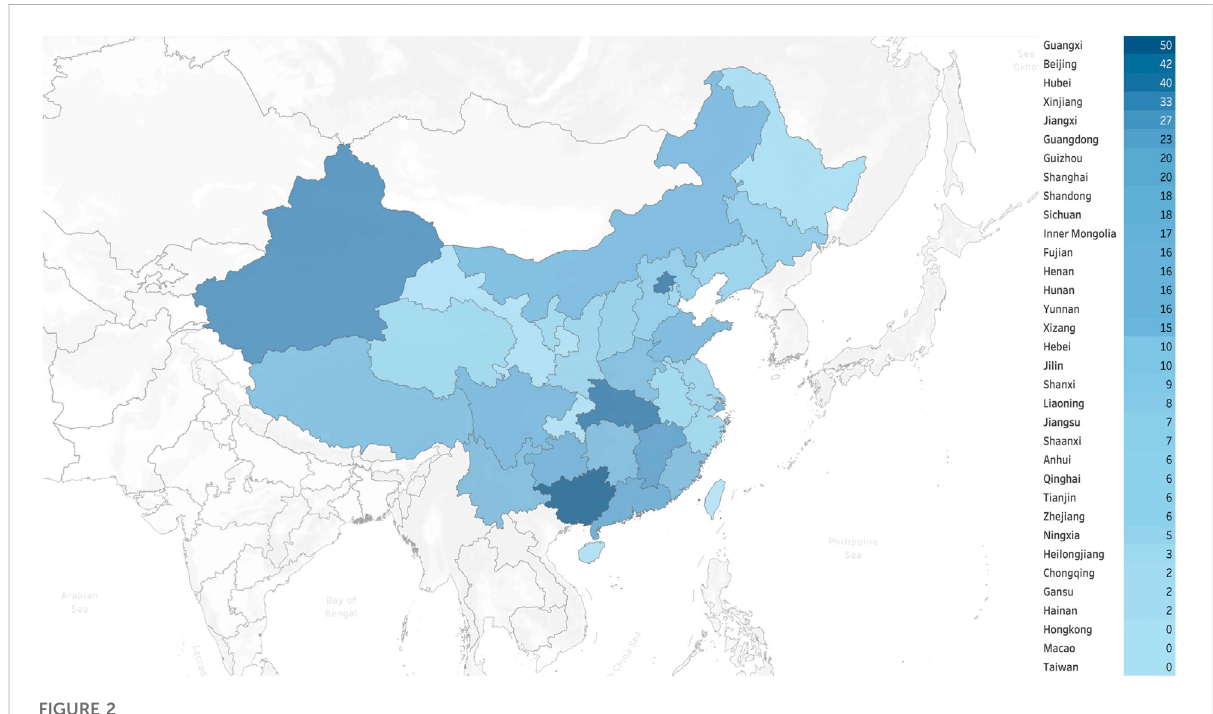
FIGURE 2 Geographical distribution of respondents with EI/CI experience ( n = 473) in